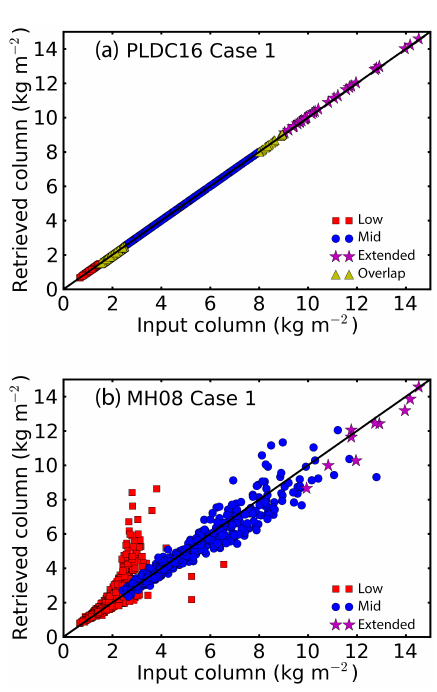
Figure 3. Comparisons of combined regime retrievals from simulated signals against the input water vapour columns for (a) PLDC16 and (b) MH08. The simulated signals are noiseless and perfect auxiliary information is provided. The black line represents a perfect